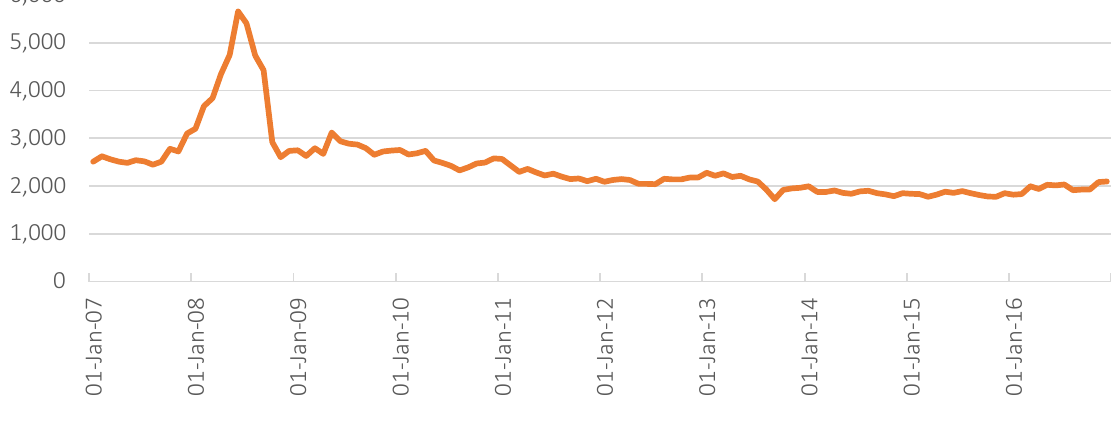
Figure 1. ASE industrial index